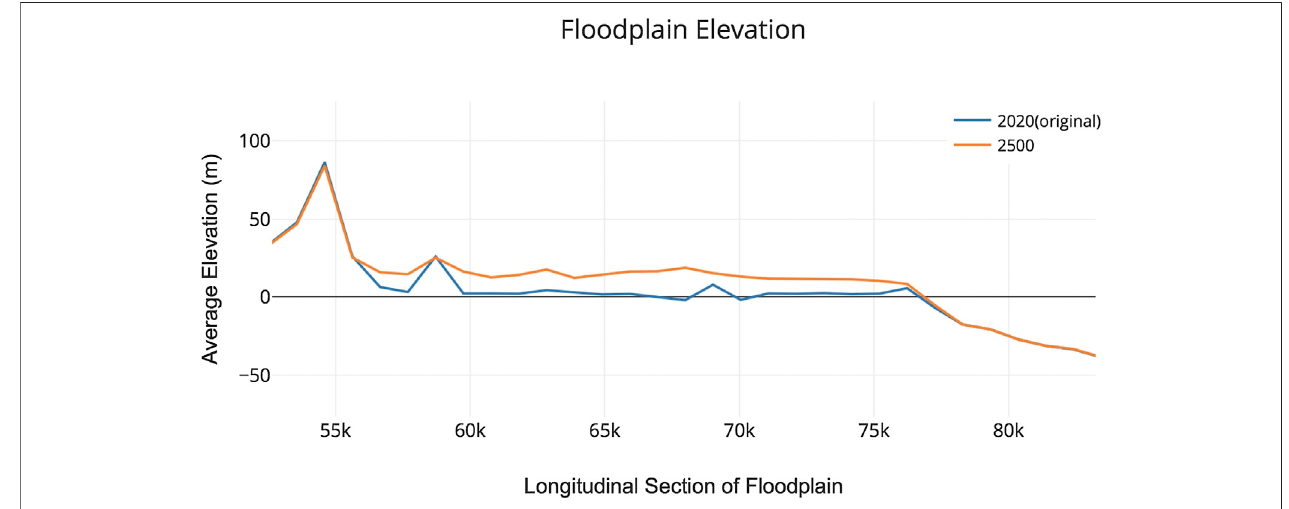
FIGURE 9 | Comparisons of fl oodplain elevation between 2020 and